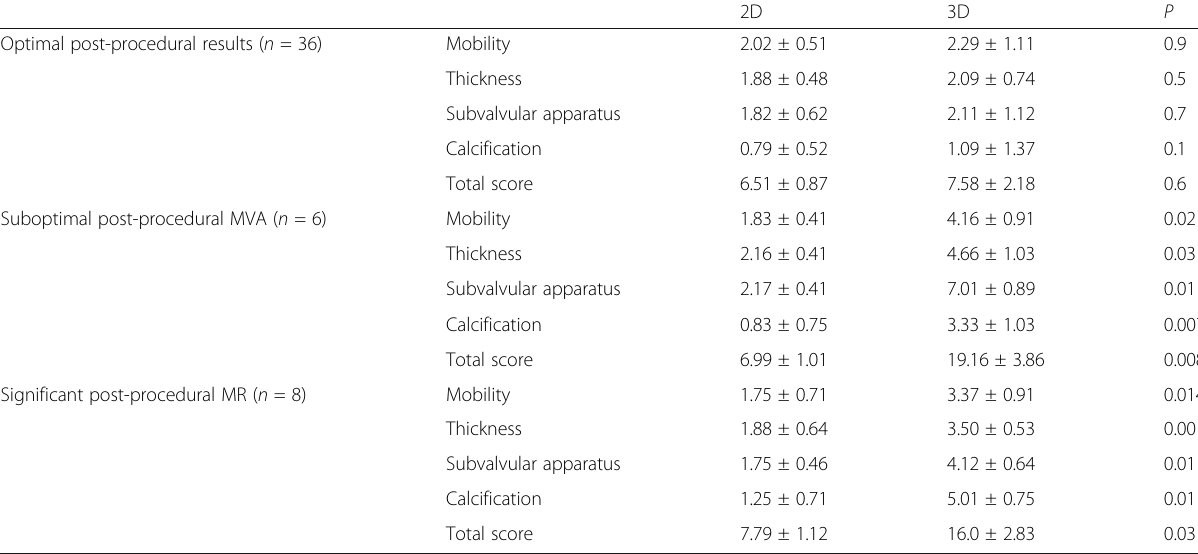
Table 2 Comparison between 2D-Wilkins score and 3D=Anwar score in cases with post-procedural optimal results, suboptimal MV area, and significant MR